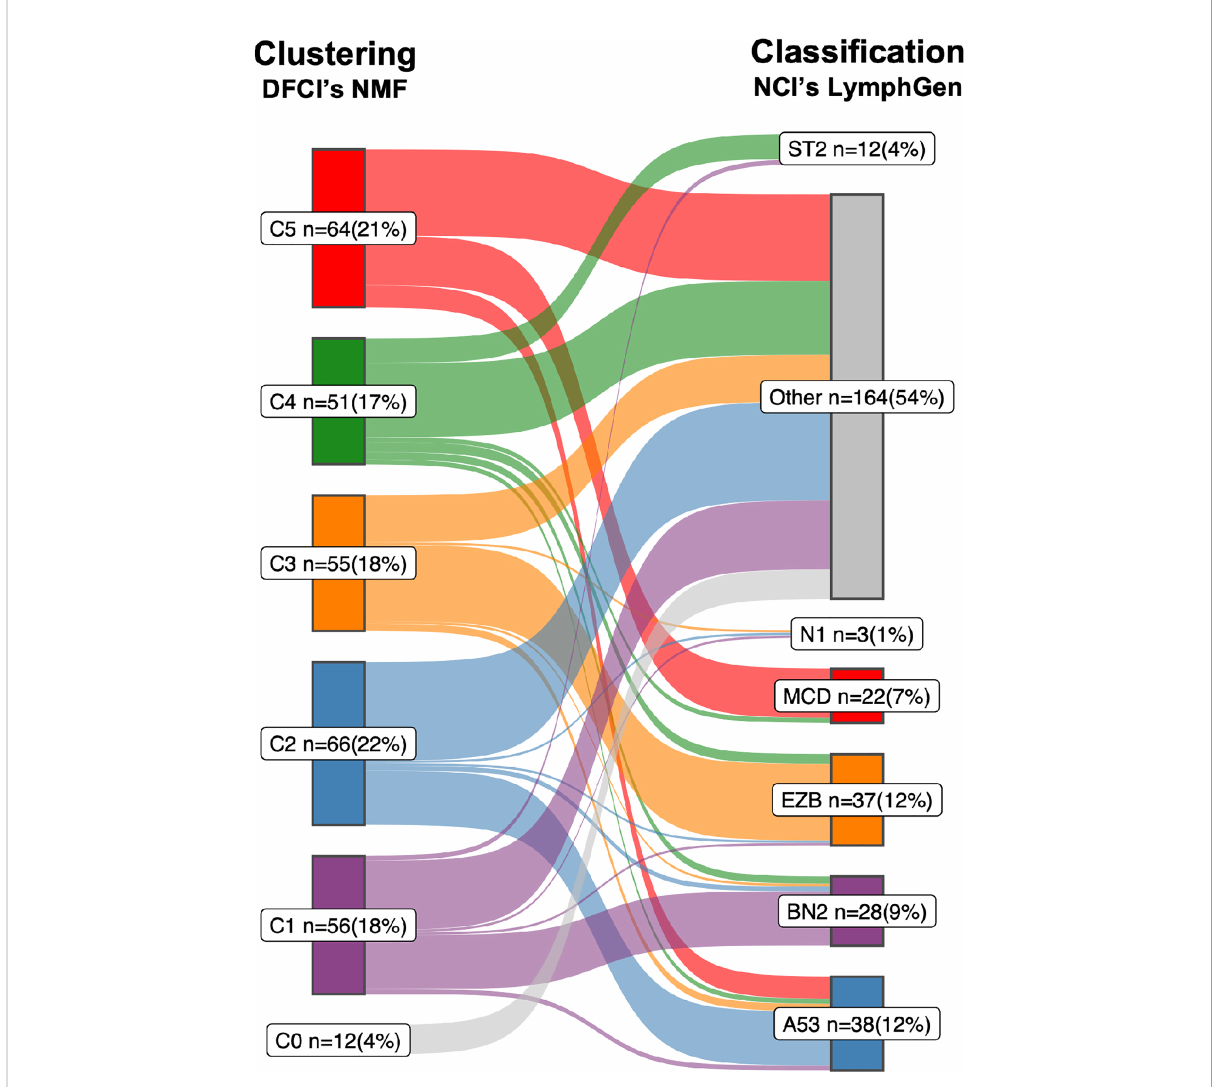
FIGURE 1 Sankey diagram comparing the two DLBCL subtypes. A Sankey diagram was constructed to illustrate how the LymphGen (12) and NMF (10) subtyping systems compare, as described in Box 1. Therefore the NGS data of 304 diffuse large B-cell lymphoma (DLBCL) cases published by the Dana Farber Cancer Institute (DFCI) (10) was used as input. Left stage: Clustering by means of non-negative matrix factorization (NMF). Right stage: Classi fi cation by means of LymphGen algorithm. Flows between the subtypes resemble DLBCL cases and are labelled according to their molecular counterpart; C1/BN2, purple; C2/A53, blue; C3/EZB, orange; C4/ST2, green; C5/MCD, red; samples not assigned to a cluster (NMF, C0) or unclassi fi ed (LymphGen, Other) are in gray. Each subtype with numbers of samples (n) and percentage of total